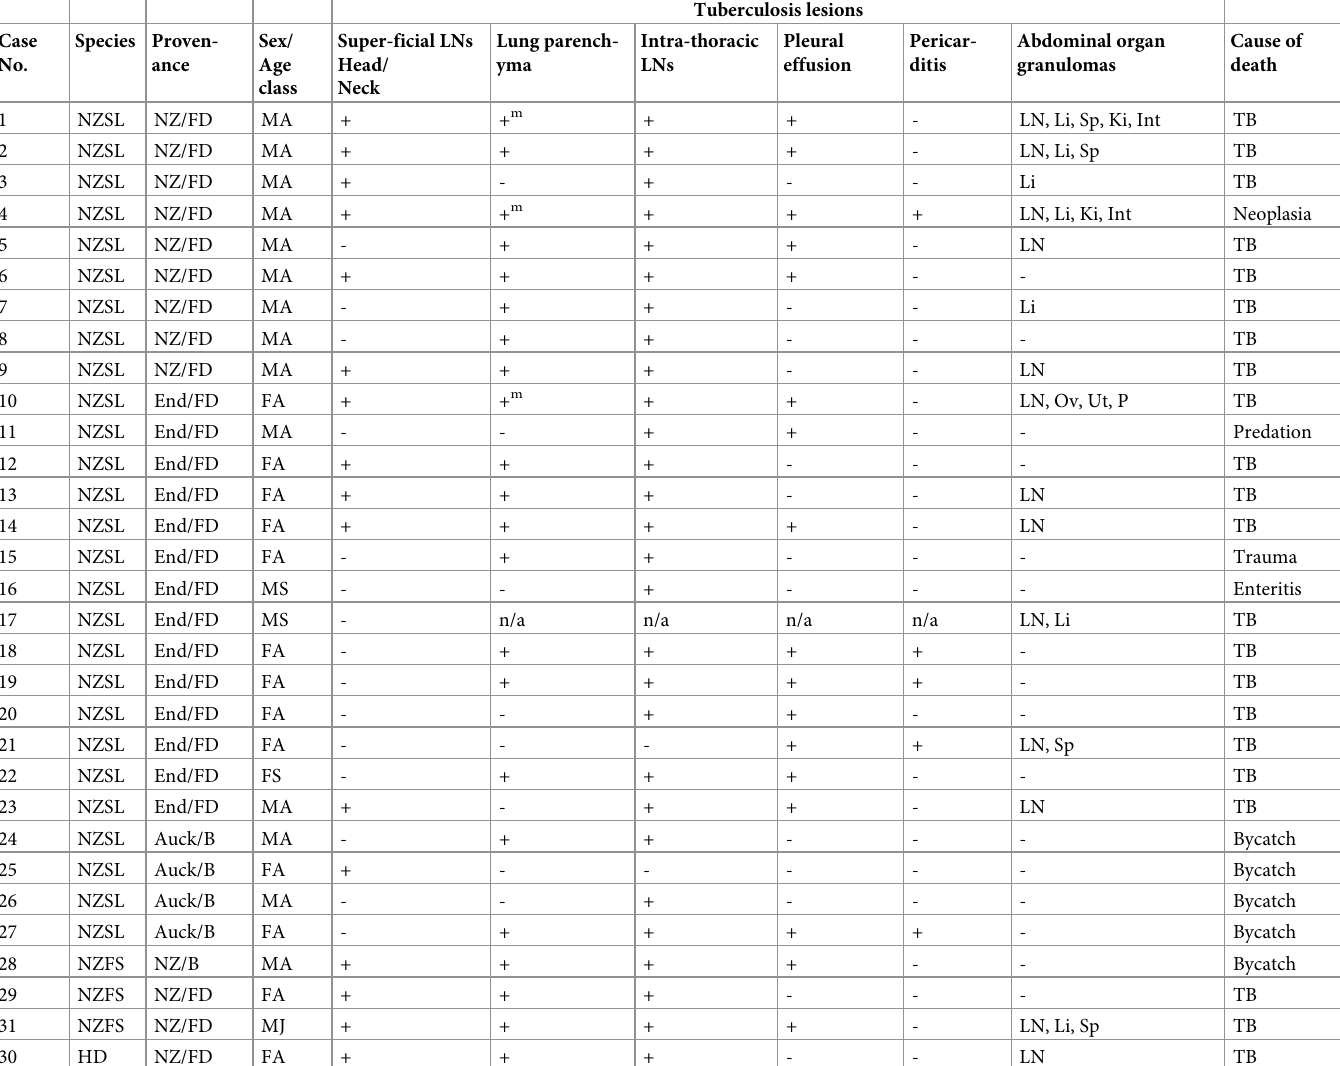
Table 1. Case details and gross lesions present in marine mammals diagnosed with